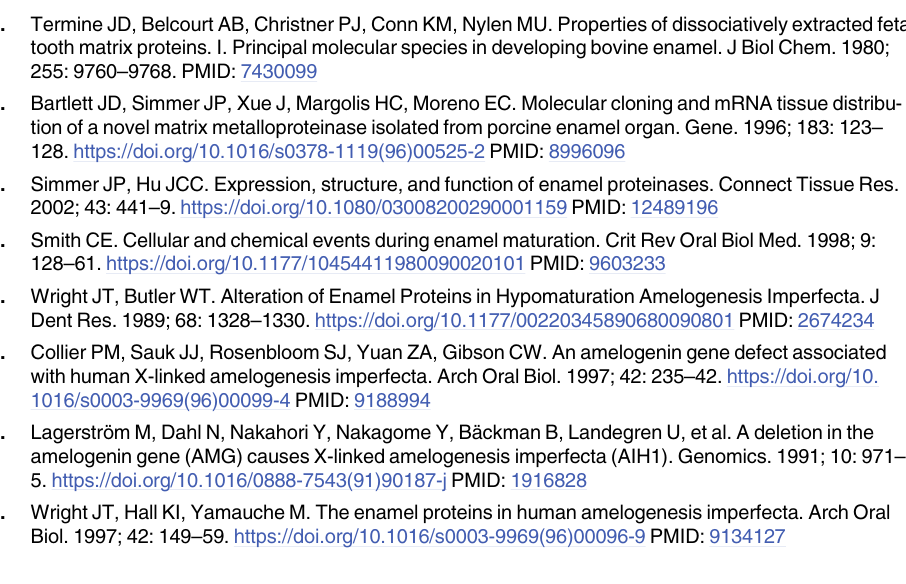
S1 Table. Sequences for target gene